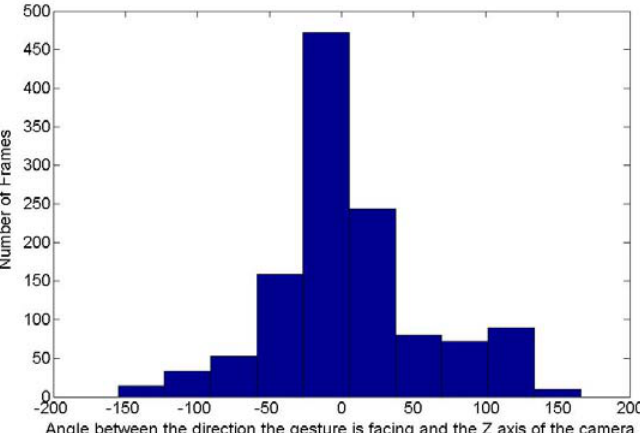
Figure 15. Values of angles between the direction the hand segment is facing and the Z axis of the camera for the frames acquired for the posture